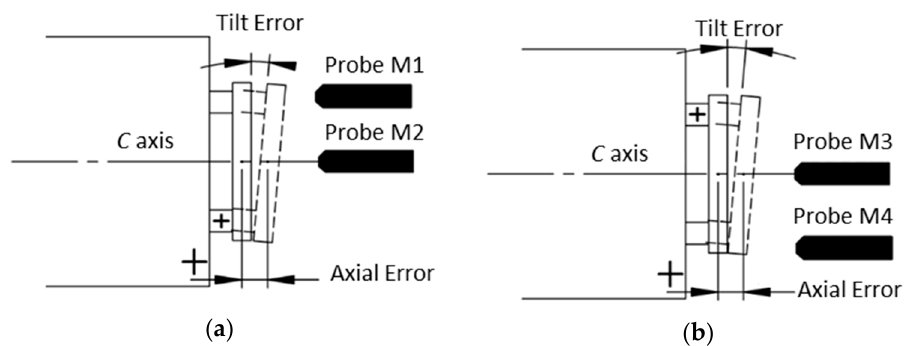
Figure 9. Schematic diagram of the facial reversal method. ( a ) Before reversal operation, ( b ) After reversal operation.